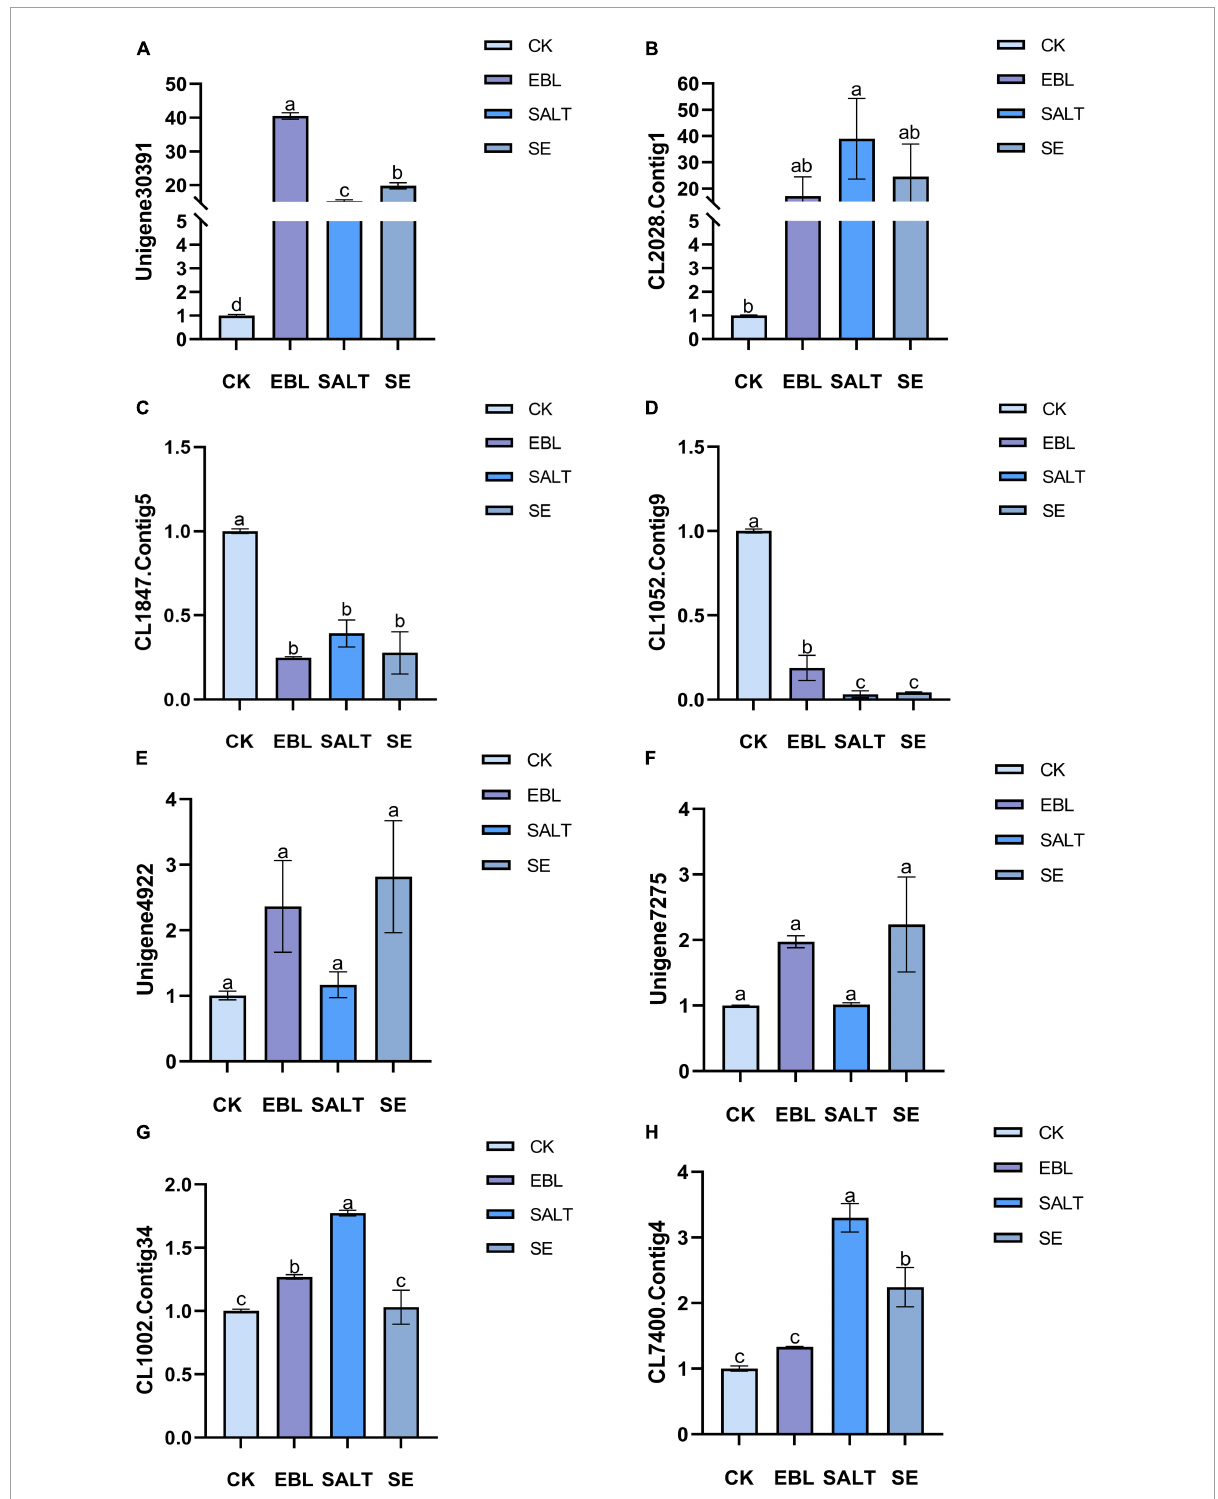
FIGURE7 Quantitative real-time PCR (qRT-pCR) analysis of several differentially expressed genes in tall fescue. (A) Relative expression of Unigene30391; (B) Relative expression of CL2028.Contig1; (C) Relative expression of CL1847.Contig5; (D) Relative expression of CL1052.Contig9; (E) Relative expression of Unigene4922; (F) Relative expression of Unigene7275; (G) Relative expression of CL1002.Contig34; (H) Relative expression of CL7400.Contig4. Bars with different letters indicate significant difference at P ≤ 0.05 (Duncan